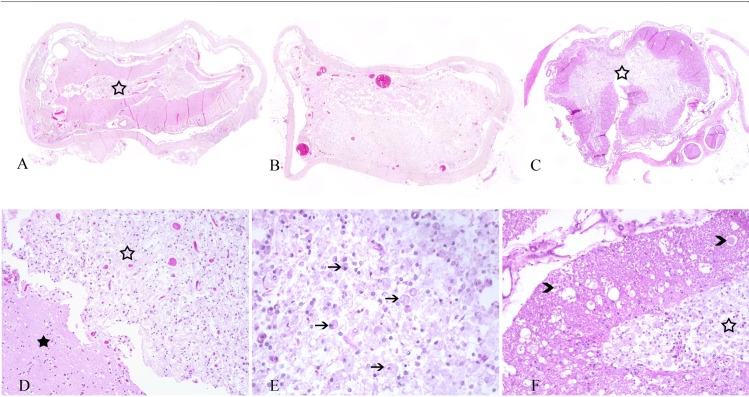
Overview of haematoxylin and eosin-stained sections of the spinal cord epicentre of the 3 dogs with severe, chronic spinal cord injury.Patient ID 7: severe myelomalacia, especially prominent in the grey matter (open asterisk) (A). Patient ID 11: severe pan-myelomalacia with complete loss of organotypic architecture and distinction between grey and white matter (B). Patient ID 16: severe myelomalacia with accentuation in the grey matter (asterisk) (C). Patient ID 7: myelomalacia with gliosis in the grey matter (open asterisk), while the white matter (asterisk) is less prominently affected (D). Patient ID 16: grey matter with severe gliosis and infiltration of phagocytic gitter cells (arrows) (E). Patient ID 16: severe malacia with gitter cell infiltration within the grey matter (open asterisk) (F). The white matter exhibits multiple dilated myelin sheaths and several axonal spheroids (arrowheads).